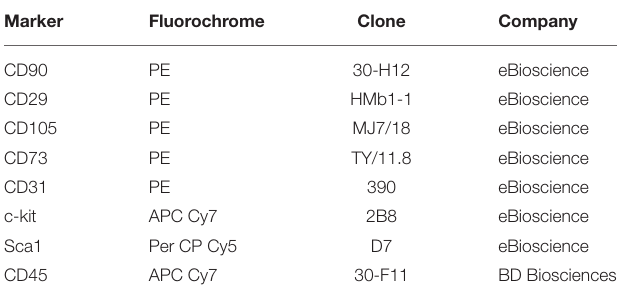
TABLE 1 | Monoclonal antibody list.